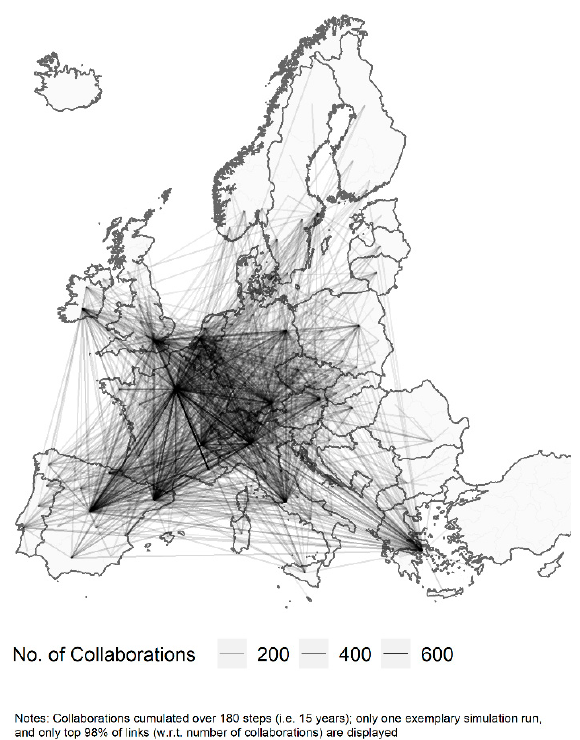
Figure 5. European inter-regional R&D collaboration network.